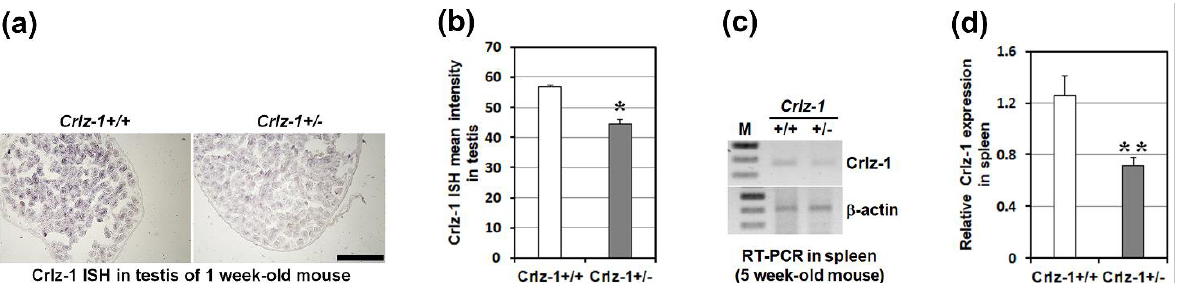
Figure 5. Crlz-1 was expressed haploinsufficiently in its heterozygous KO mice. ( a , c ) The haploinsufficient expression of Crlz-1 in its heterozygous KO mouse ( Crlz-1 +/ − ) was demonstrated in 1-week-old mouse testis by ISH in panel a, as well as in 5-week-old mouse spleen by RT-PCR in panel c, as compared to its expression in the wild-type littermate ( Crlz-1 +/+ ). ( b , d ) The ISH signal intensities from four representative tissue sections of each genotyped mouse testis as in panel a, and the RT-PCR signal intensities from four wild-type and three heterozygous spleens as in panel c, were statistically processed using the ImageJ program to obtain bar graphs with error bars of SEM in panels b and d, respectively. M: DNA size marker. Scale bar in panel a: 1 mm. * p ≤ 0.0005, ** p ≤